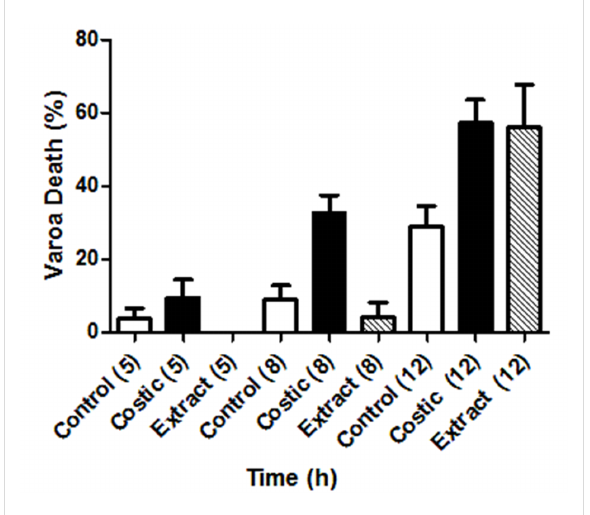
Figure 2: Time dependence of the mortality (%) of V. destructor after a 60 μ L dose. The number in parenthesis indicates the number of hours that the mites were exposed to the acaricides. “Costic” indicates use of costic acid solution and “extract” refers to the solution of the total